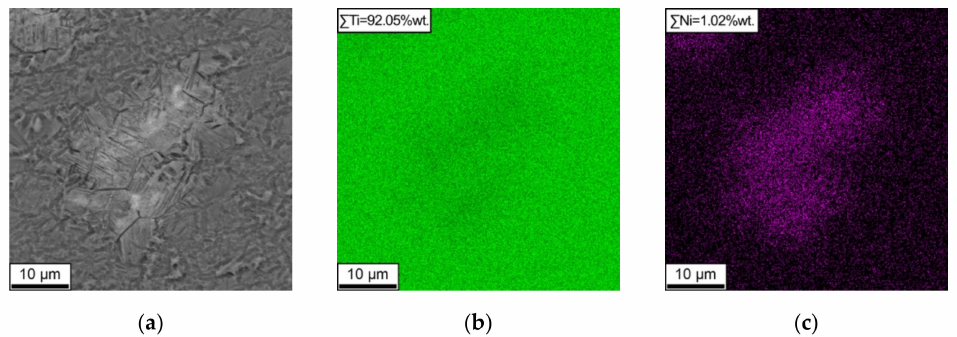
Figure 7. EDX-mapping of the stir zone area with inclusions in sample 1: ( a ) BSE-image; ( b ) titanium and ( c ) nickel distribution.